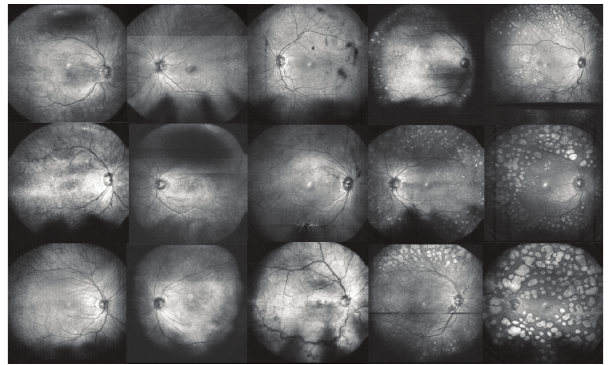
Figure 1: Reconstructed en face wide-field fundus images of all 15 patients; artifacts are shown in detail in Figure